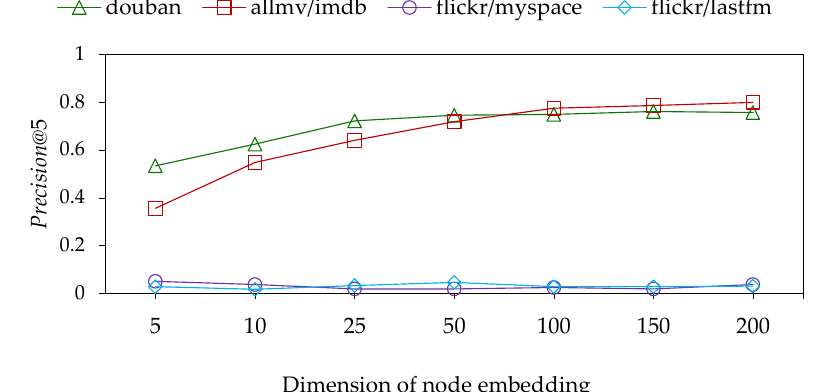
Figure 4. Effect of embedding dimension on Precision @5.